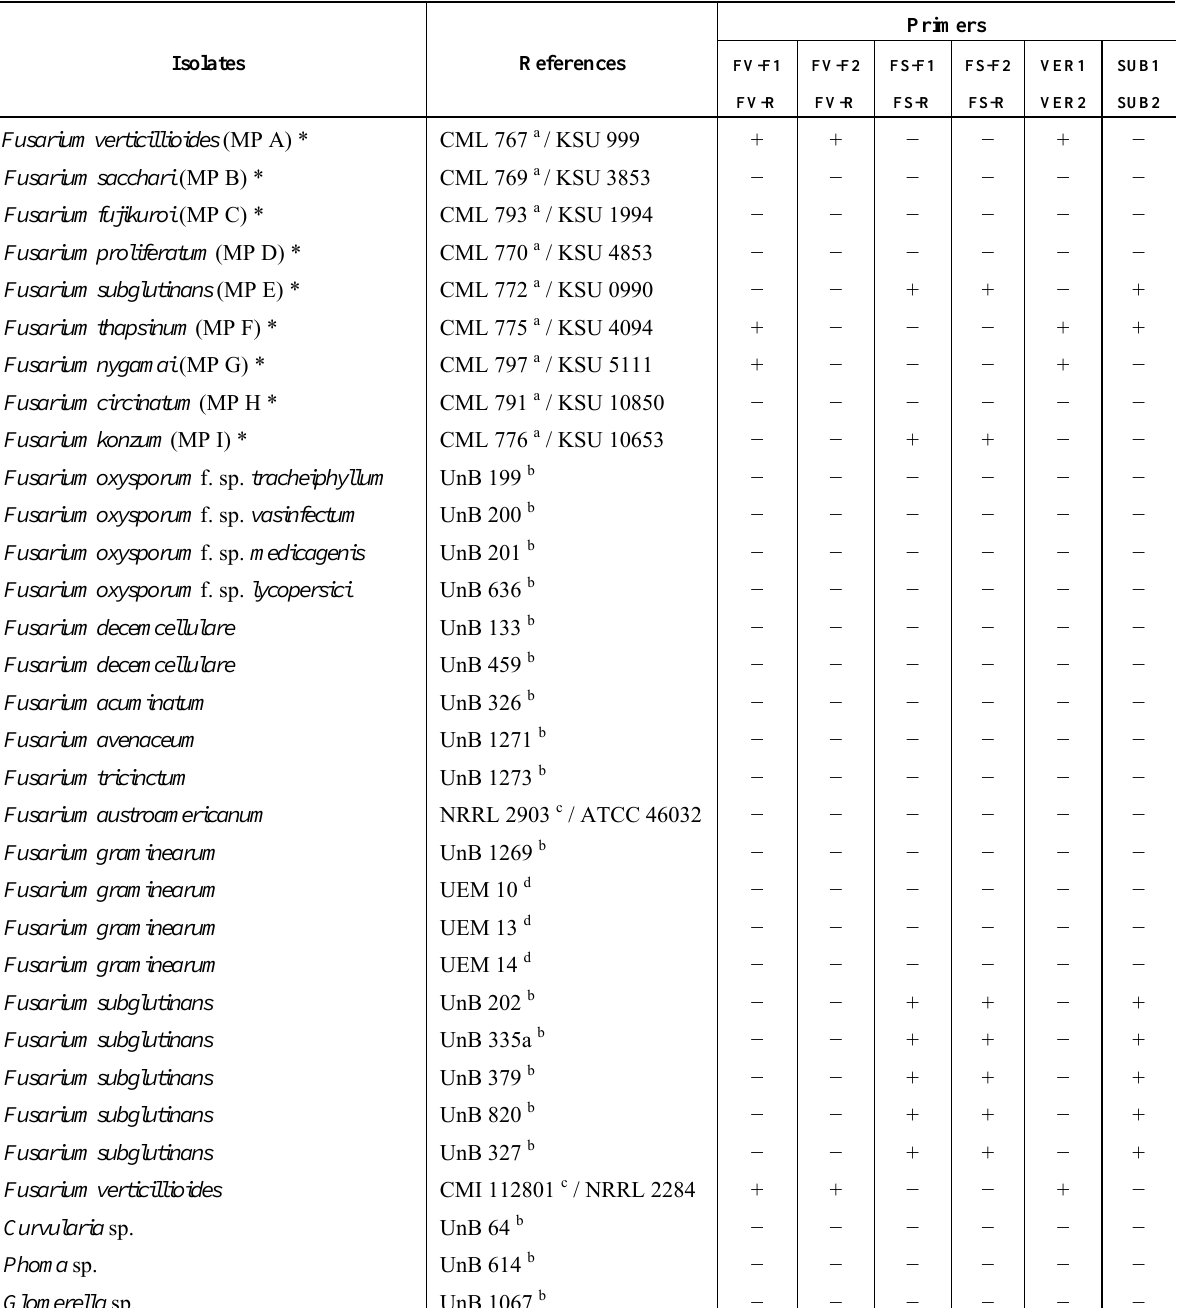
Table 1. Fungal isolates used in this study and PCR results with the indicated primers.